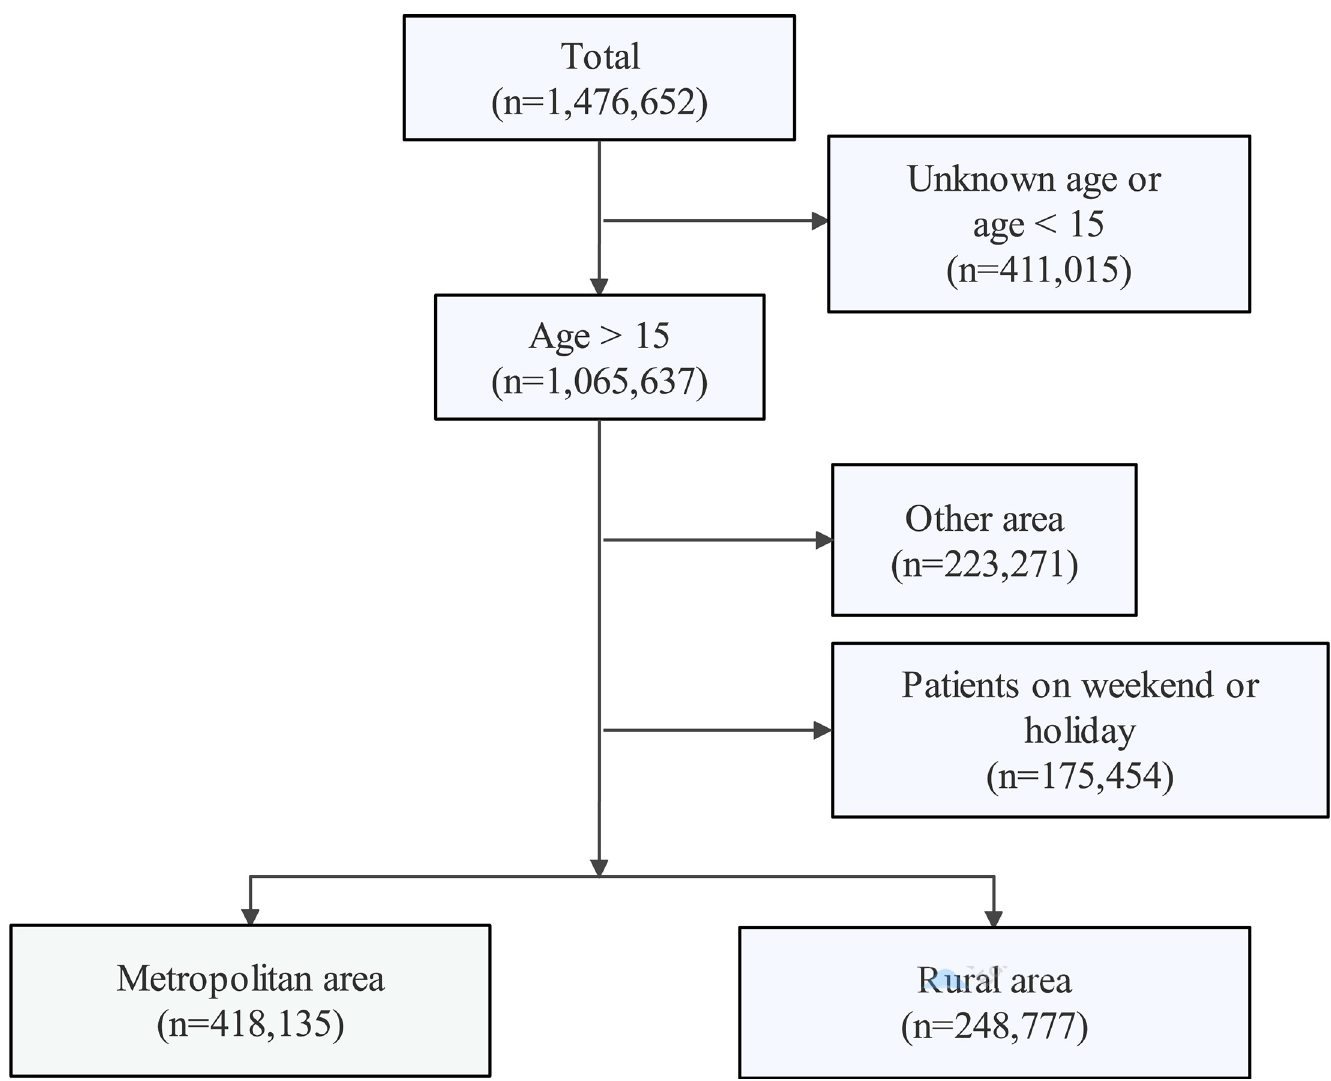
Fig 1. Schematic diagram showing the selection of study population for this